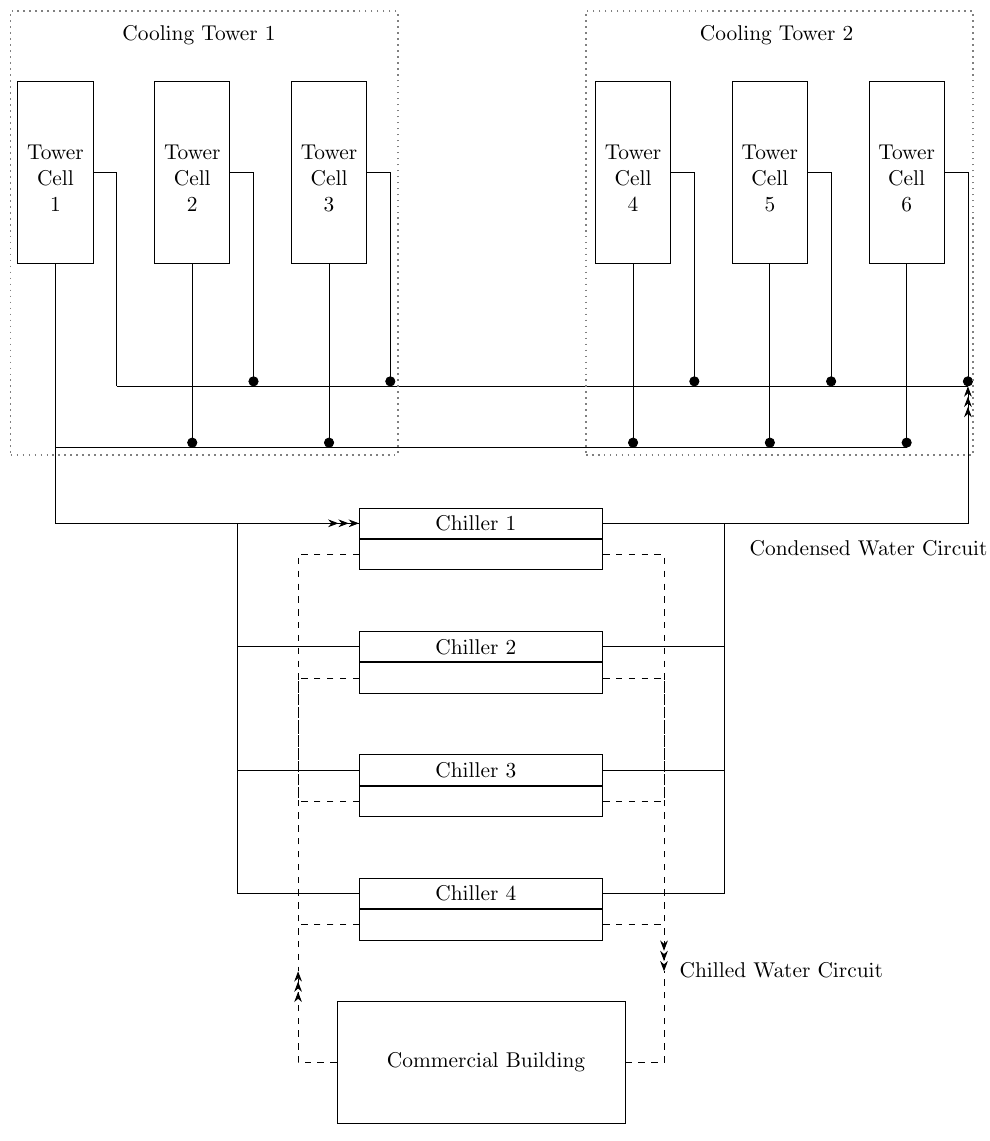
Figure 1. Refrigeration system’s